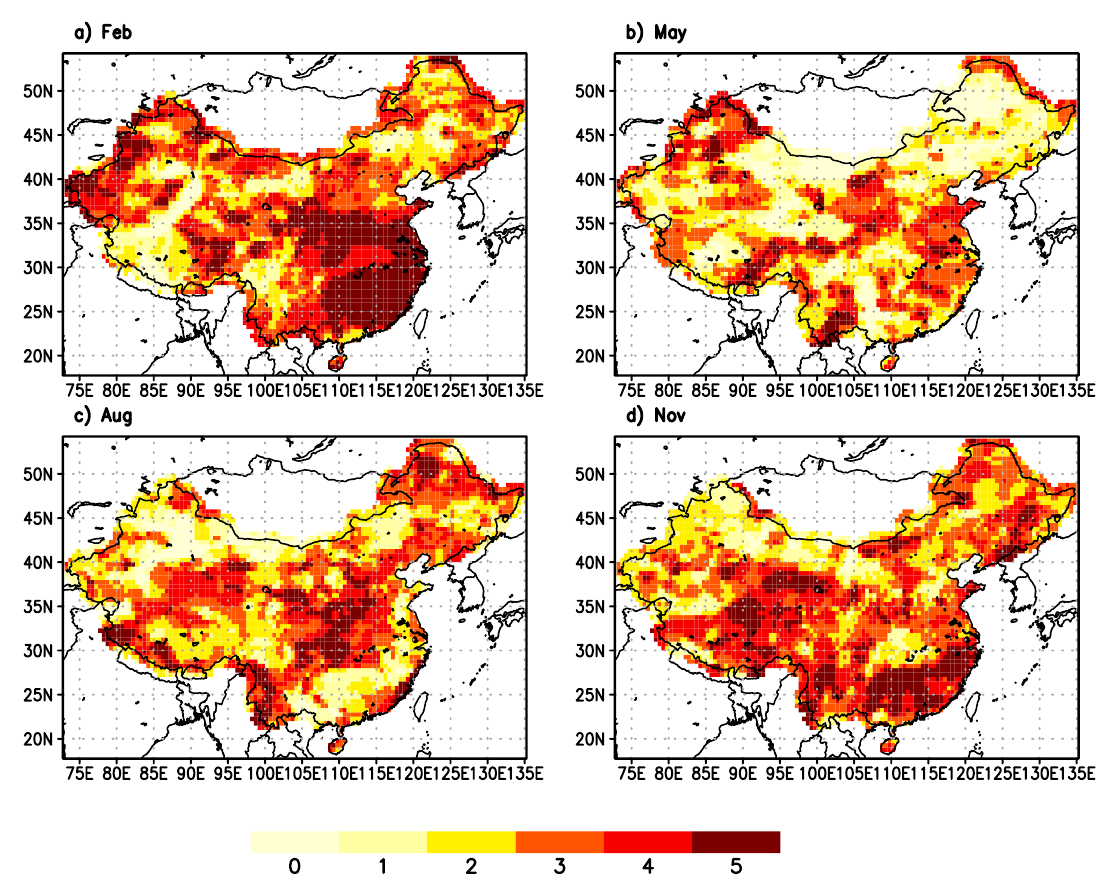
Figure 6. The maximum lead time in months that the CFSv2 precipitation forecast shows better skills than persistence measured by correlation TAC. A similar result was obtained when measured by the